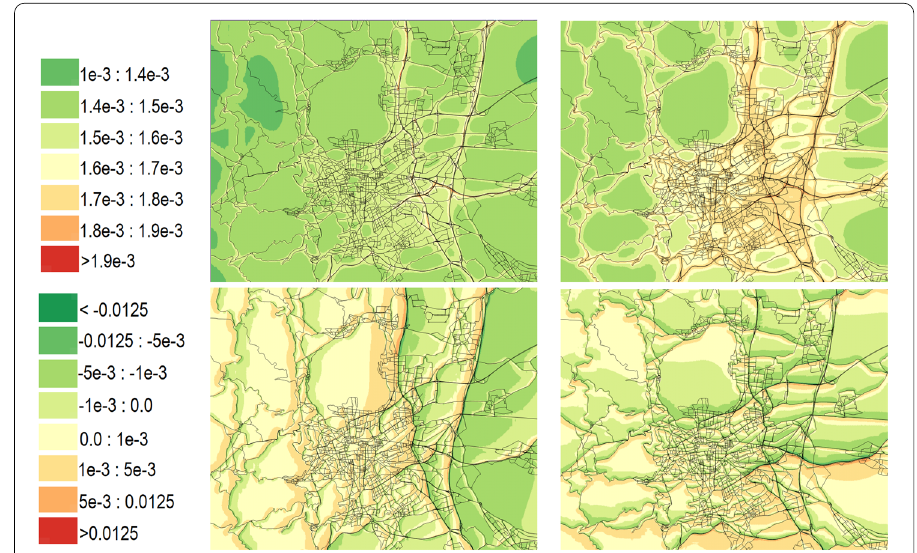
Fig. 6 First four principal components of the NO 2 concentration field mass matrix. Concentrations are represented in µ gm − 3 . The top legend corresponds to the first principal component, which displays smaller variations. The bottom legend corresponds to the other three principal